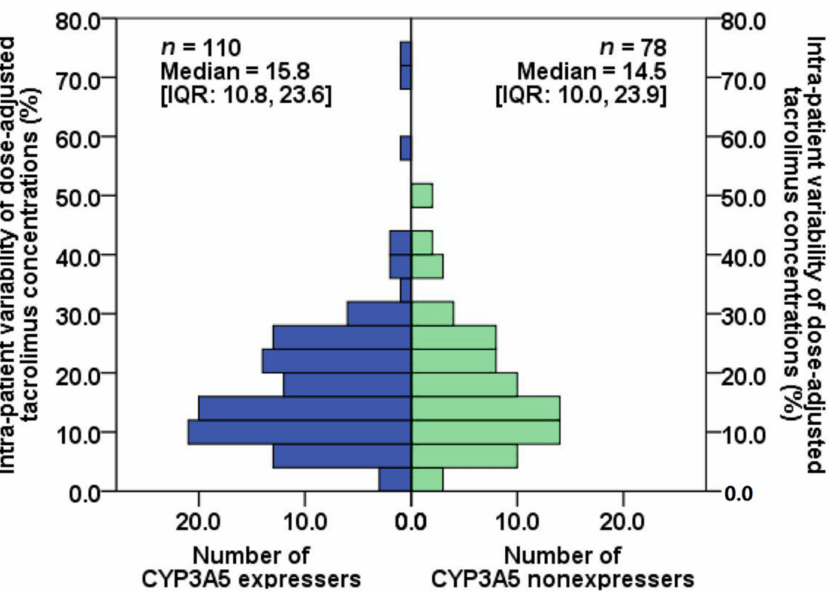
Figure 4. Frequency distributions of intra-patient variability of tacrolimus dose-adjusted trough concentrations estimated by coefficient of variation in CYP3A5 expressers and